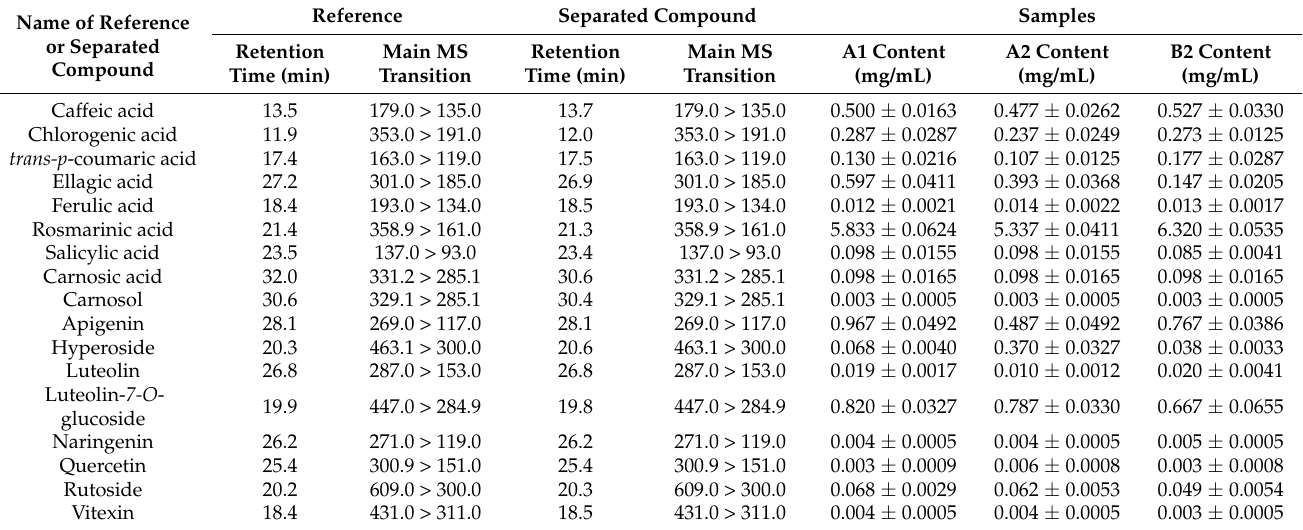
Table 2. The identified and quantified components of D. moldavica samples (mg/mL extract) collected using LC–MS analysis.